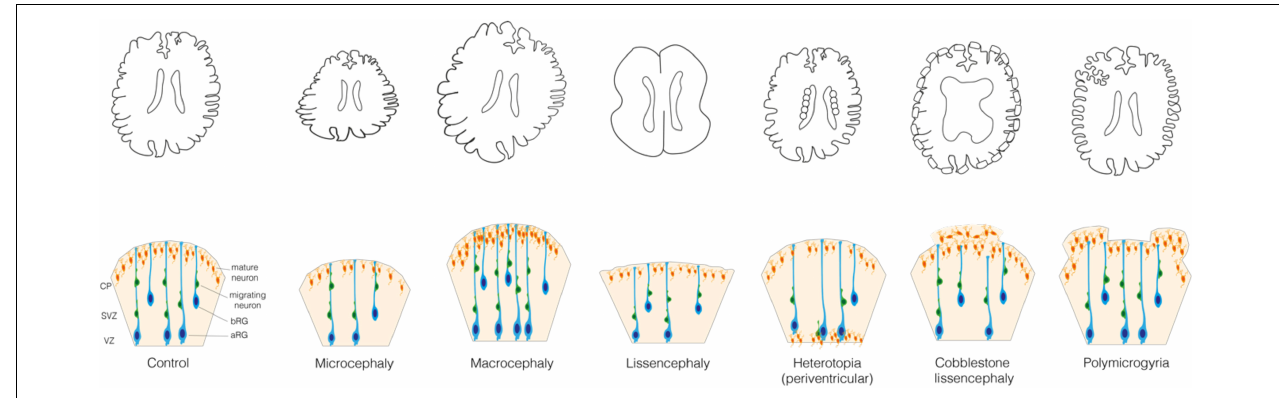
FIGURE 1 | Malformations of the cortical development. (Upper) Schematic representations of the control brain and brains affected by the following MCDs: microcephaly, macrocephaly, lissencephaly, periventricular nodular heterotopia, cobblestone lissencephaly and polymicrogyria. (Lower) Schematic representation of the mechanisms underlying these MCDs. In Control: VZ, ventricular zone; SVZ, subventricular zone; CP, cortical plate; aRG, apical radial glia; bRG, basal radial glia; migrating and mature